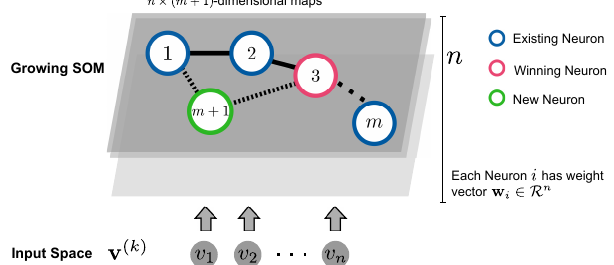
Figure 1: An example framework of Growing SOM illustrating the concept of the winner neuron and creation of new nodes in the network. The layers in GSOM, shaded gray planes stacked on top of each other, are maps of n -dimensional feature